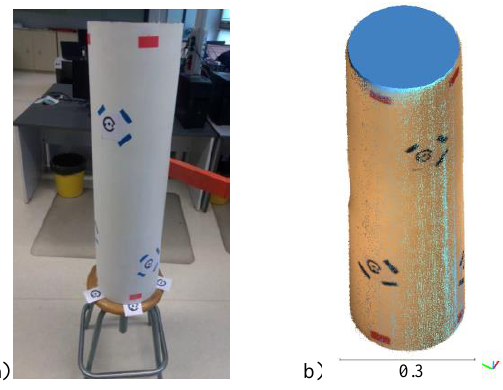
Figure 6. (a) The cylinder considered in this experiment, with additional targets. (b) Example of a cylindrical primitive adjusted in a colorized point cloud.